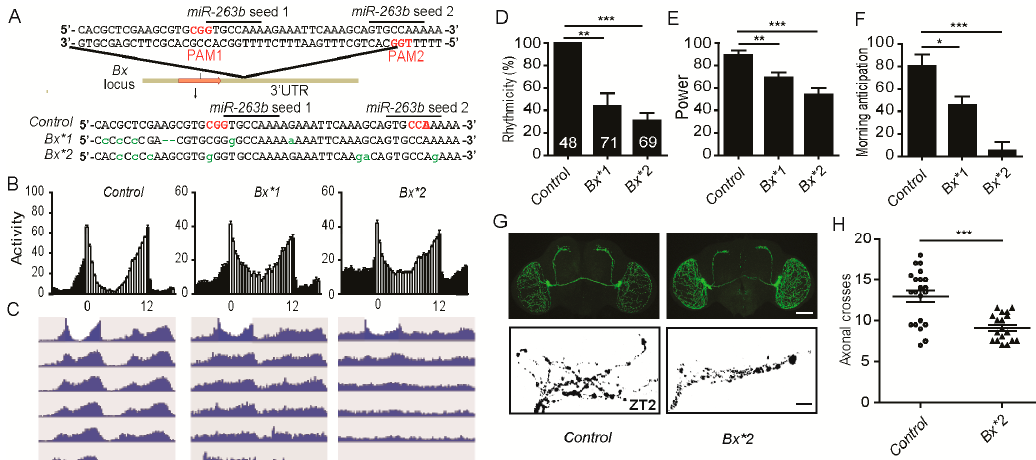
Figure 7. Mutation of the miR-263b binding site in the Bx 3 ′ UTR leads to behavioral arrhythmicity. ( A ) Sequence in the miR-263b binding site region in the Bx 3 ′ UTR and mutations induced using the CRISPR/Cas9 system. ( B ) Locomotor activity of adult male flies of indicated strains measured during four days of LD cycles and five days of DD. The white and black bars indicate day and night, respectively. ( C ) Actograms showing the average activities on the last day in LD and the five days in DD. Light represents the day, and gray represents darkness. ( D – F ) Comparison of ( D ) rhythmicity, ( E ) power, and ( F ) morning anticipation in indicated genotypes. The numbers of tested flies are shown in each column. Data represent means ± SEM ( n = 48–69). ( G ) Representative confocal images of control and Bx*2 fly brains stained for PDF at ZT2; scale bar, 75 µm for the whole-mount figure, and 10 µm for the magnified images. ( H ) Quantification of axonal morphology from control and Bx*2 flies. Data represent means ± SEM ( n = 18–21); * p < 0.05, ** p < 0.01, *** p < 0.001 determined by Student’s t -test.